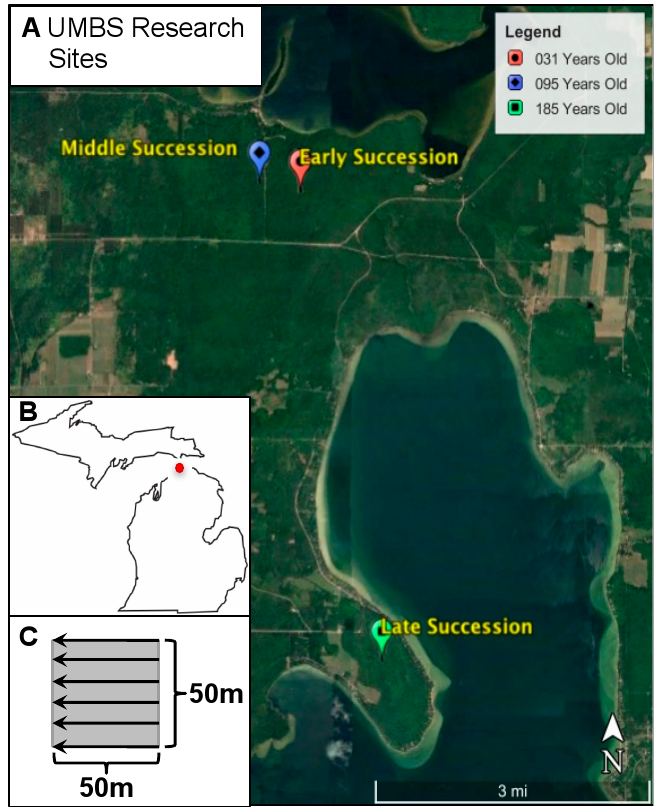
Figure 1. Research sites and sampling strategy. Location of early, middle, and late successional research sites ( A ) in Michigan (( B ), red circle) with sampling design at each site ( C ), showing orientation and spacing of portable canopy LiDAR (PCL) and ground penetrating radar (GPR) transects (black arrows) within each 50 m × 50 m (0.25 ha) plot (grey square).